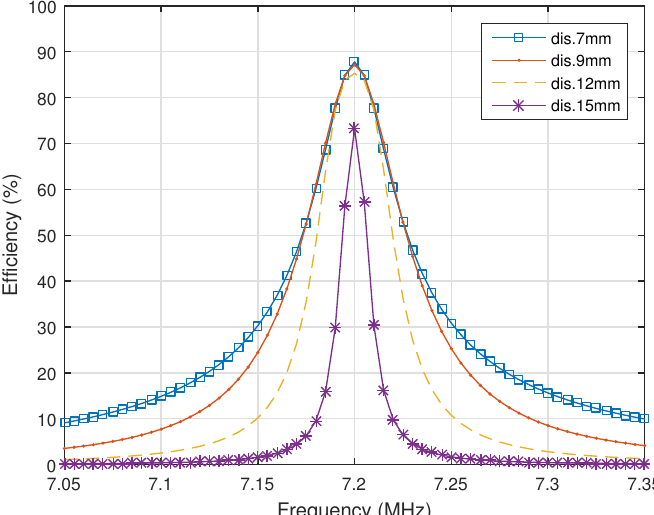
Figure 4. Simulated efficiency of the hybrid system using the calculated equation for the distance ( d 12 ) .